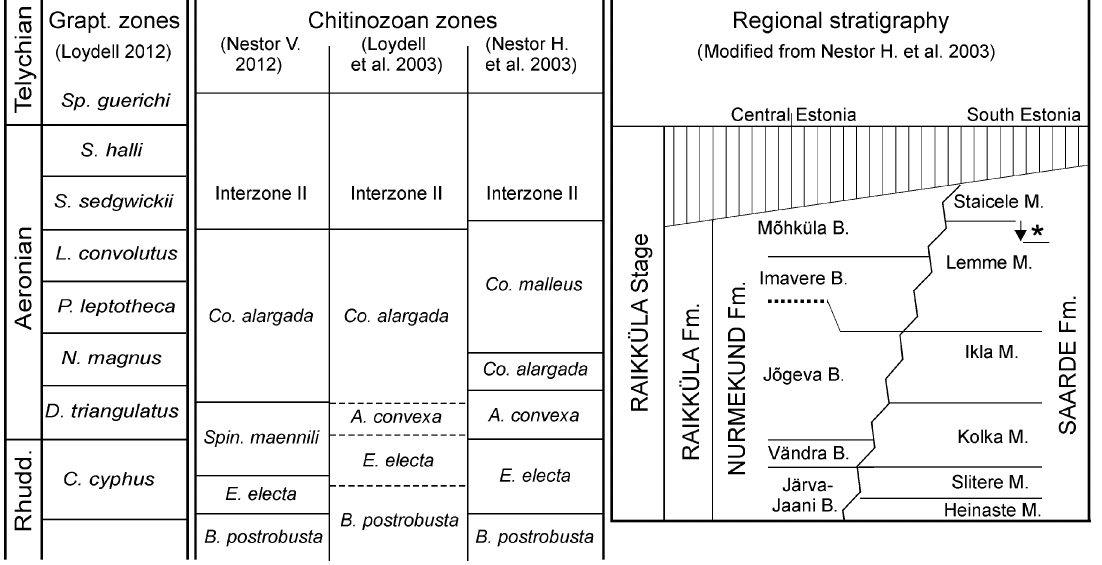
Fig. 4. Correlation of graptolite and chitinozoan biozonations, and dating of lithostratigraphical units of the Raikküla Stage. Our data suggest that at least in central Estonia the upper part of the Jõgeva Beds is younger than indicated in Nestor H. et al. (2003) and correlates with the Pribylograptus leptotheca GZ (thick dotted line). Also, according to Nestor V. (2012), the lowermost Staicele Member might be older than suggested by Nestor H. et al. (2003) and corresponds to the Lituigraptus convolutus GZ (indicated by the arrow with *). Abbreviations: A ., Ancyrochitina ; B ., Belonechitina ; C ., Coronograptus ; Co ., Conochitina ; D ., Demirastrites ; E ., Euconochitina ; L ., Lituigraptus ; N ., Neodiplograptus ; P ., Pribylograptus ; S ., Stimulograptus ; Sp ., Spirograptus ; Spin ., Spinachitina